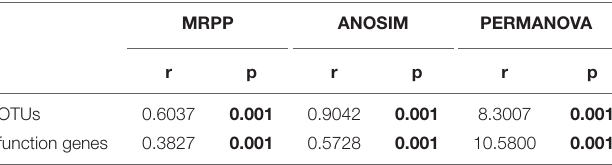
TABLE 1 | Dissimilarity tests of OTUs and predicted function genes (by PICRUSt) based on Bray-Curtis distance. MRPP ANOSIM